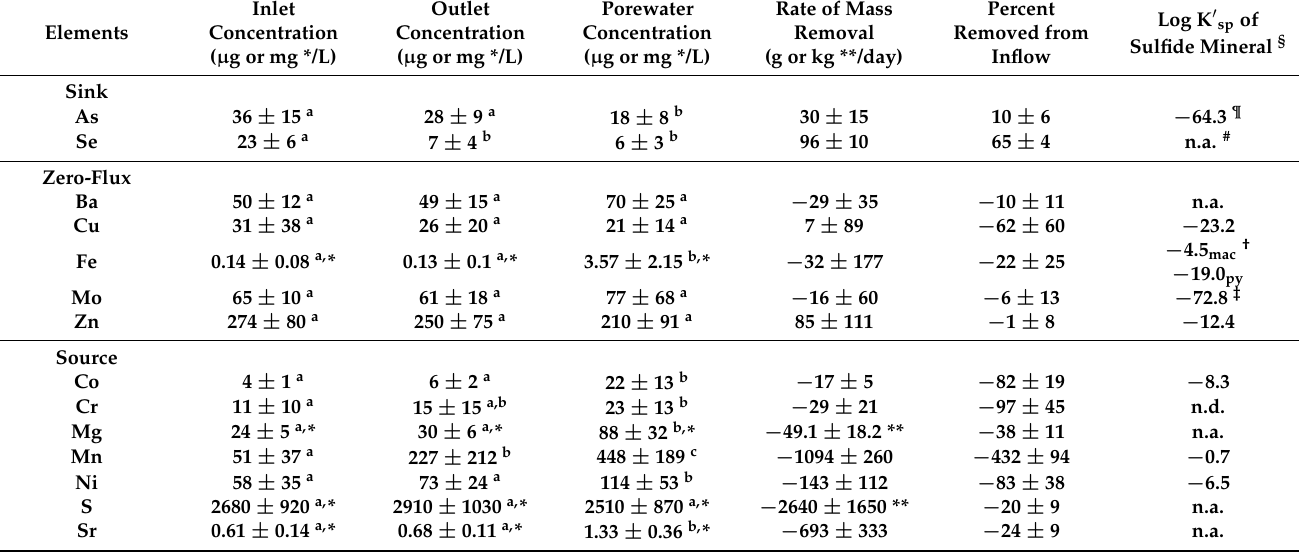
Table 2. Pooled (16 week) mean values for total metal, As, Se and S concentrations in inlet, outlet and porewaters ( µ g or mg */L ± standard deviation), removal rate (g or kg **/day ± standard error) and percent removed from inlow ( ± standard error) for Sink, Zero-flux and Source elements measured during the study period. Value superscripts ( a–c ) indicate statistically significant differences (ANOVA, p < 0.05, Tukey–Kramer). ( n = 16 for inlet and outlet values; n = 60–80 for porewater values). Selected solubility product constants for sulfide minerals corresponding to the measured